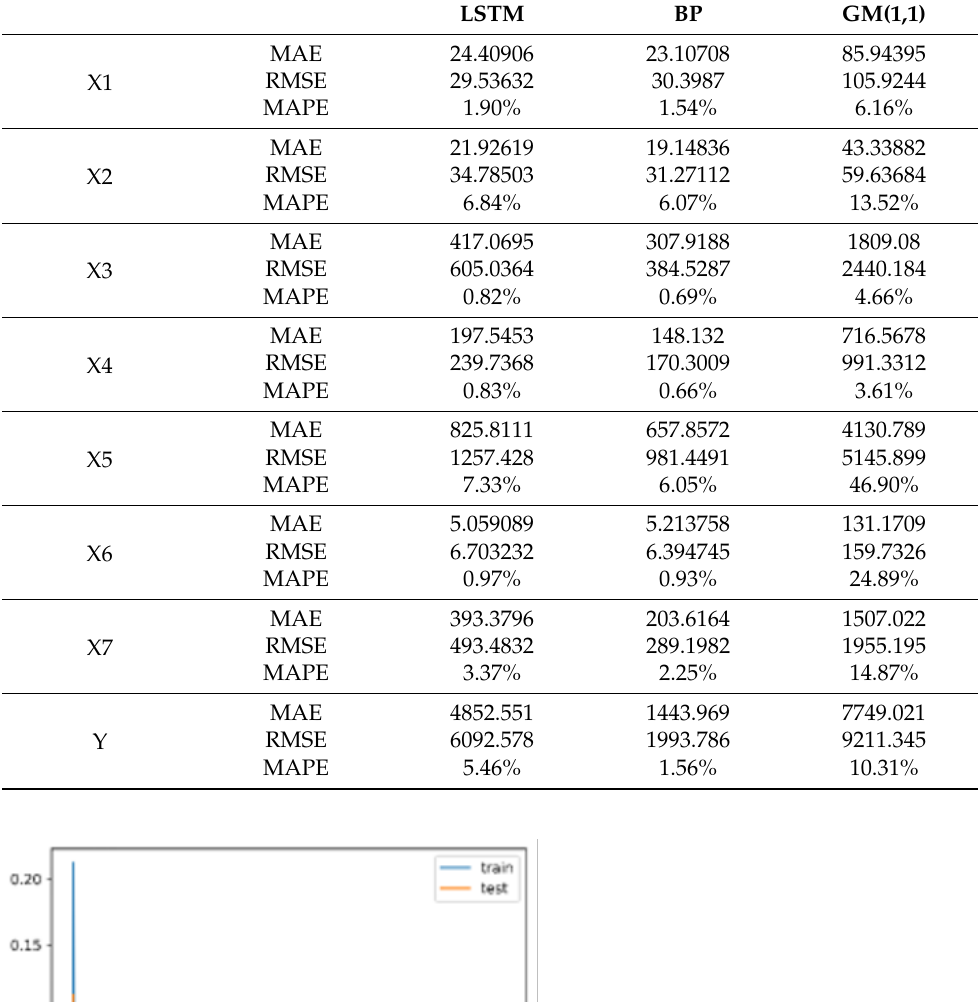
Table 5. Accuracy of factor prediction.